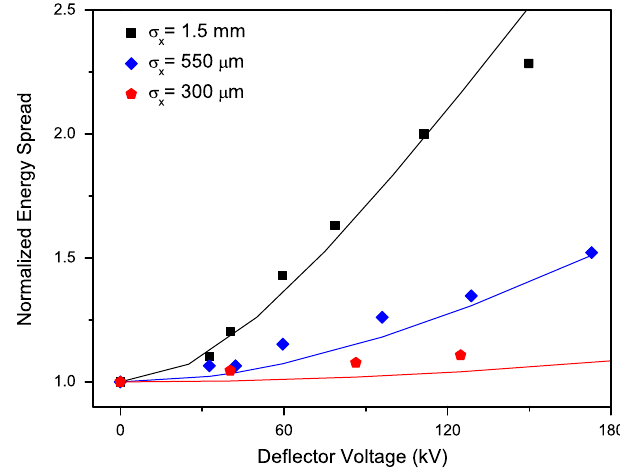
FIG. 2. (Color) A study of the Panofsky-Wenzel theorem in the deflecting cavity. The normalized energy spread is plotted versus the deflecting voltages for a given transverse spot size in the cavity shown as points are compared to the analytical result of a deflecting kick shown by